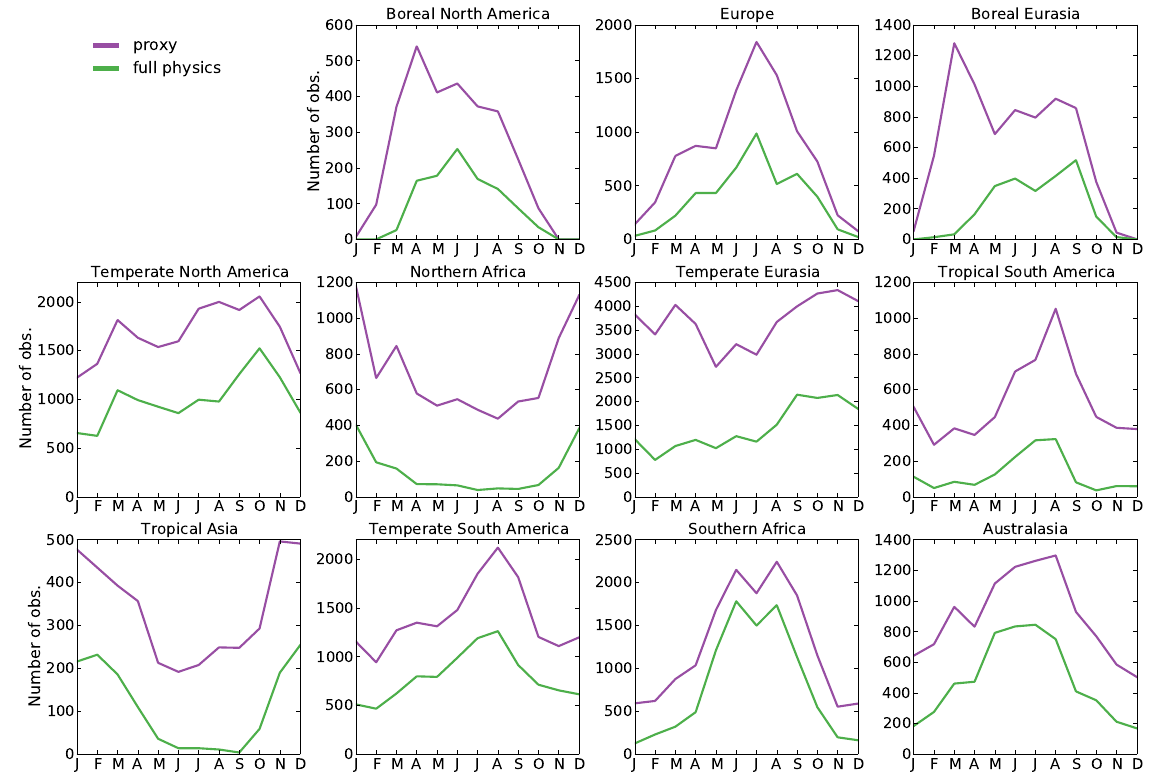
Figure 2. The number of GOSAT observations available per month during 2010 over specific geographical regions (Fig. 1) from the full- physics XCO 2 and proxy XCH 4 retrieval